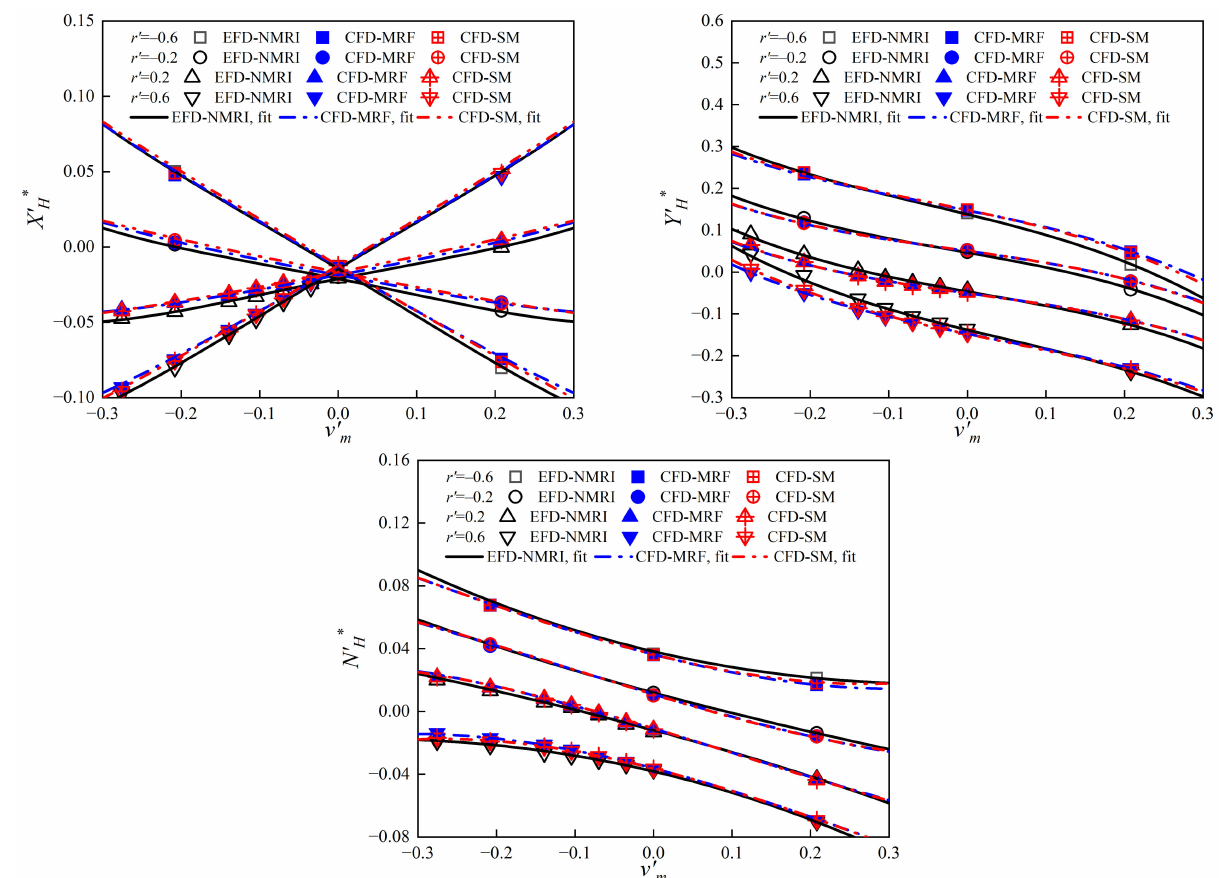
Figure 13. Hydrodynamic forces on the hull obtained from CMTs ( β (cid:54) = 0 ◦ ) and corresponding fitting curves.